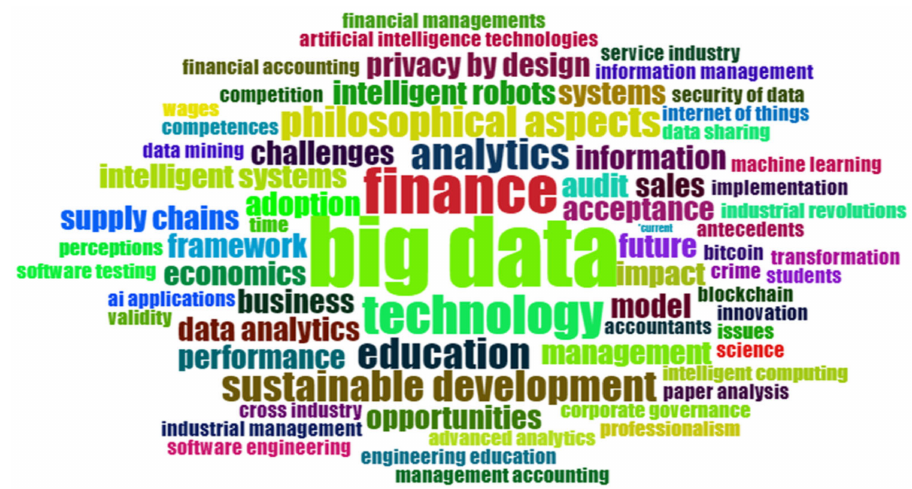
Figure 2. Overview of key terms provided by the analyzed literature.